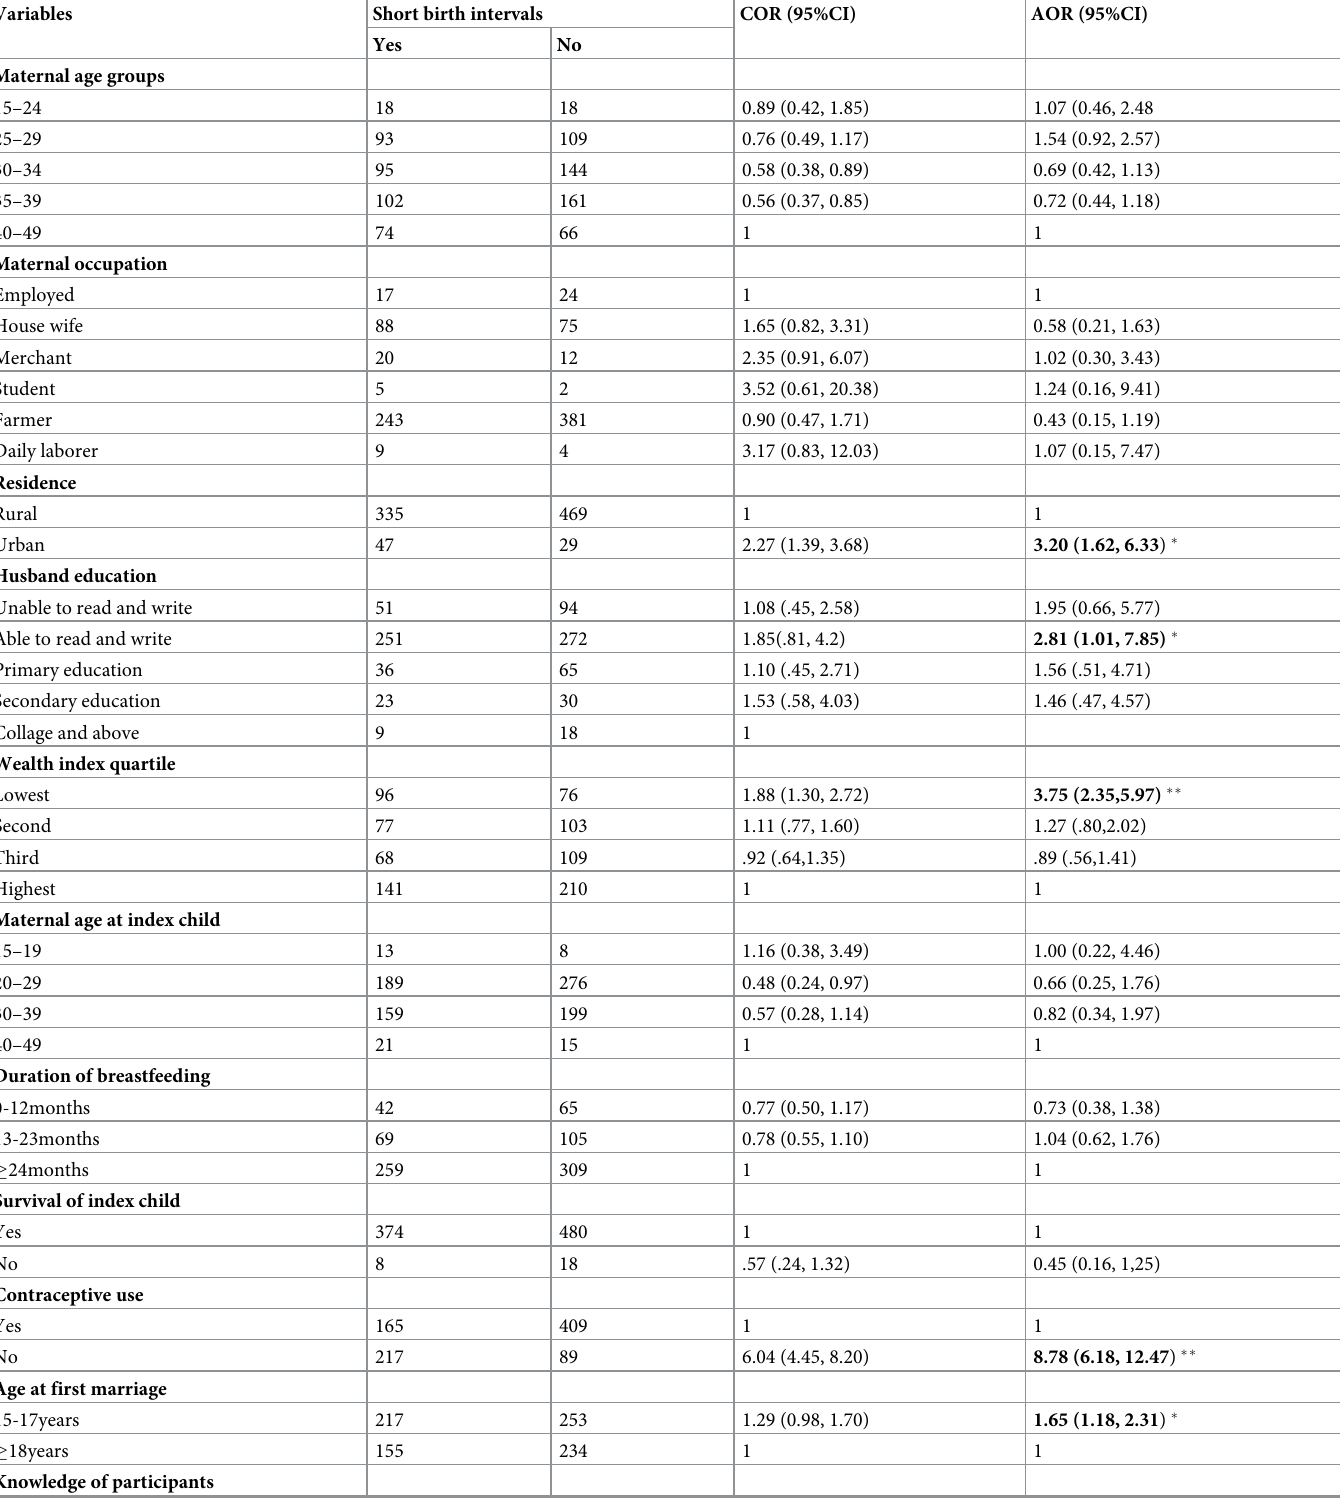
Table 5. Bivariable and multivariable analysis of factors associated with short birth intervals in Dembecha district, Northwest Ethiopia, 2019 (n =